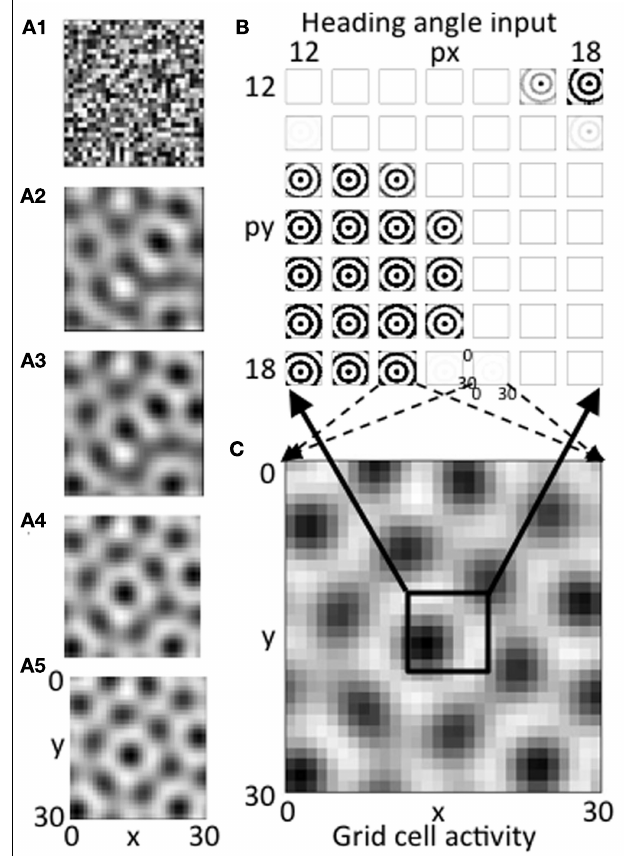
FIGURE 3 | (A1–A5) The evolution of activity in the grid cell plane at different stages during the iterative interaction.The network starts with random activity that then evolves into a hexagonal array of firing fields in a manner similar to continuous attractor dynamics models of grid cells. (B) Example of the magnitude of synaptic input at a single time step at the end of the simulation for a 7 by 7 set of heading angle cell arrays.The full simulation contains 30 spatial phases in the px dimension and 30 in the py dimension, but only a 7 by 7 array of spatial phases from the center is shown (phases 12–18).The input from heading angle cells at a specific spatial phase is determined by feedback from the grid cell plane. (C) The pattern of activity in the full grid cell plane with 30 by 30 spatial phases showing how feedback regulation of the pattern of summed activity from the heading angle plane produces a grid cell firing pattern that is stable.The pattern is stable because the pattern created by summing the 30 by 30 pattern of synaptic input from the 30 by 30 array of spatial phases of heading angles (B) matches the pattern of feedback activation of the heading angle array from active cells in the 30 by 30 array of grid cells (C) .